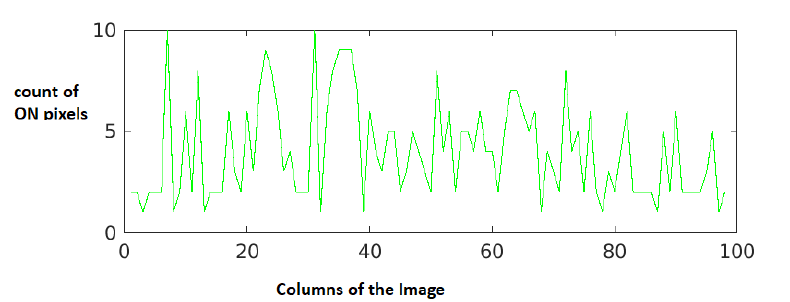
Figure 12. Histogram Projection-Line 2 (white spaces removed).